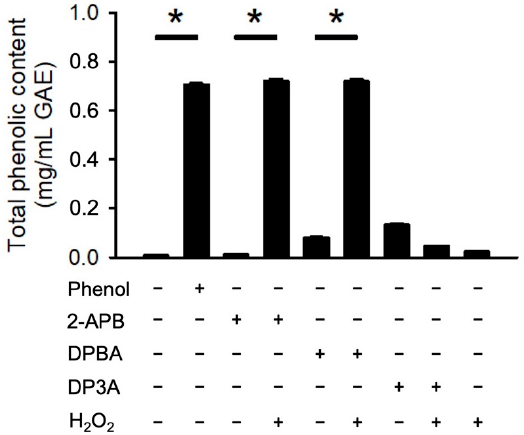
Figure 3. Generation of phenolic compounds by 2-APB analogues. 2-APB and DPBA could react with H 2 O 2 and generate phenolic compound . Generation of phenolic compounds were detected by Folin–Ciocalteu reagent (FCR). ( n = 3). * p < 0.05. Data are expressed as mean ± SEM.